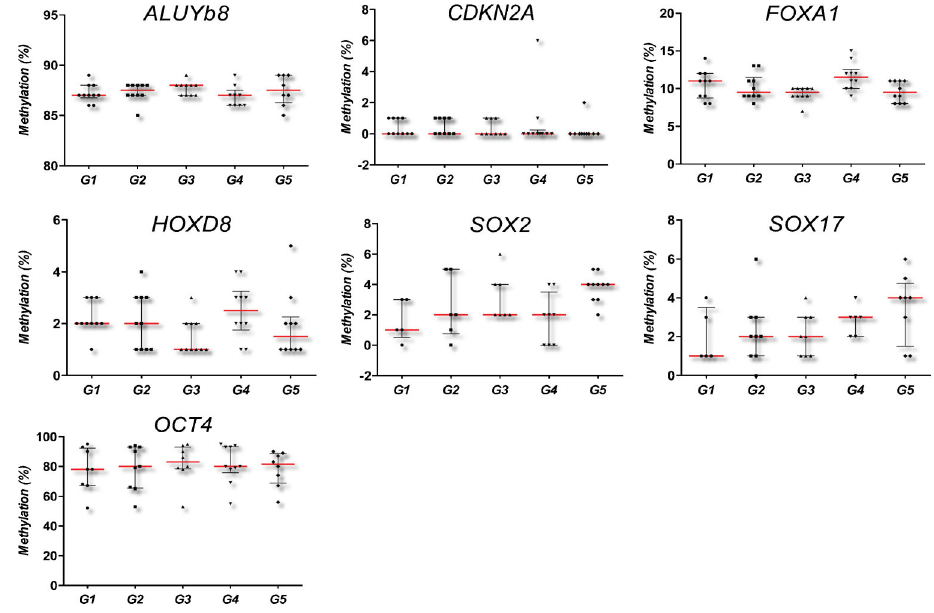
Figure 1. Dot plots representing the methylation levels of CDKN2A , FOXA1 , HOXD8 , SOX2 , SOX17 and OCT4 candidate genes, as well as of the ALUYb8 control region, in groups G1 through G5. Groups: G1: 10 patient p.R337H carriers that had developed cancer; G2: 10 patient p.R337H carriers without cancer; G3: 10 individuals with cancer and carrying germline TP53 mutations other than p.R337H; G4: 10 individuals with wild-type TP53 and relatives who are carriers of germline TP53 mutations; G5: 10 healthy individuals with no personal or family history of cancer. There were no significant differences (P . 0.05, Kruskal-Wallis